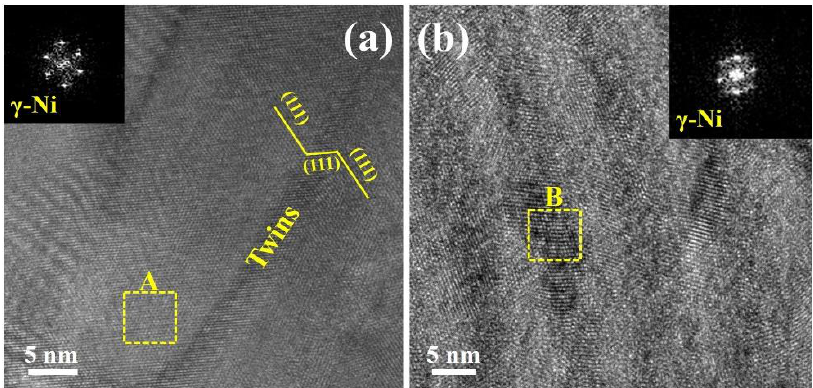
Figure 6. The HRTEM images of Ni/Ni 3 Al-MoW multilayers with varying h : ( a ) h = 40 nm and ( b ) h = 10 nm, and corresponding fast Fourier transformation results of squared regions marked A and B are shown in the inset of Figure 6a,b, respectively.